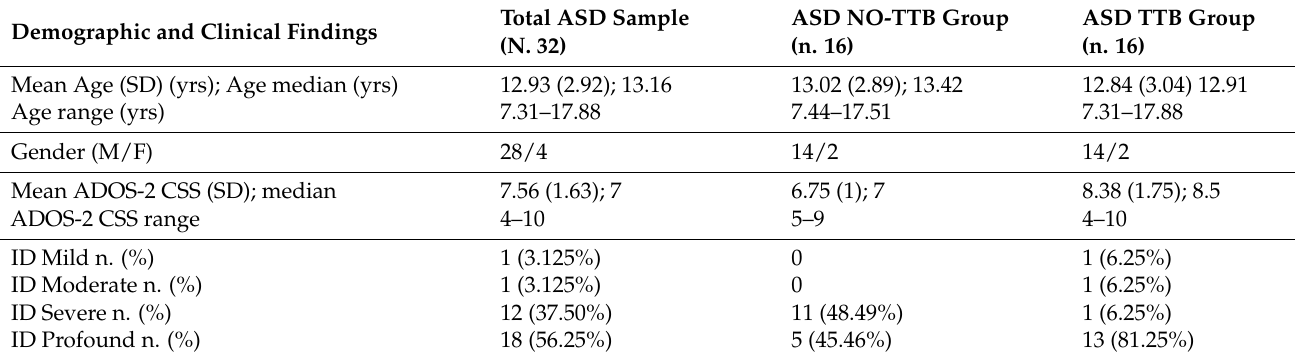
Table 1. Main demographic and clinical characteristics of the study